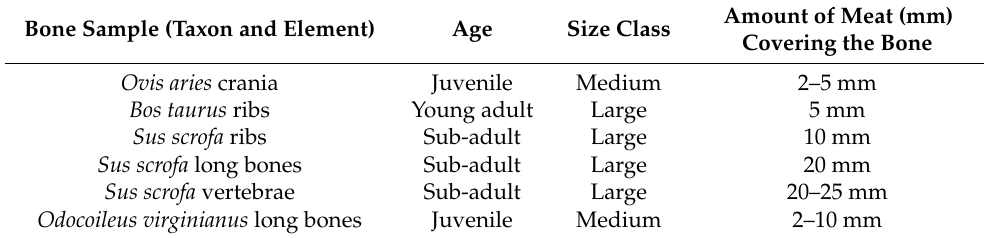
Table 2. Bone sample characteristics. Bone Sample (Taxon and